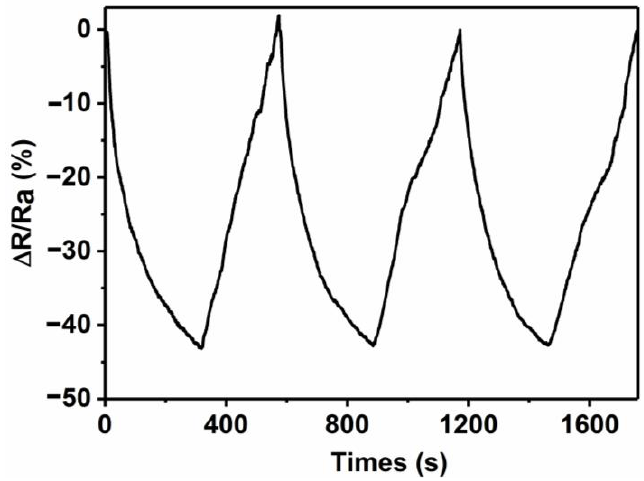
Figure 11. The repeatability and cyclic stability of the E 0 -based gas sensor.